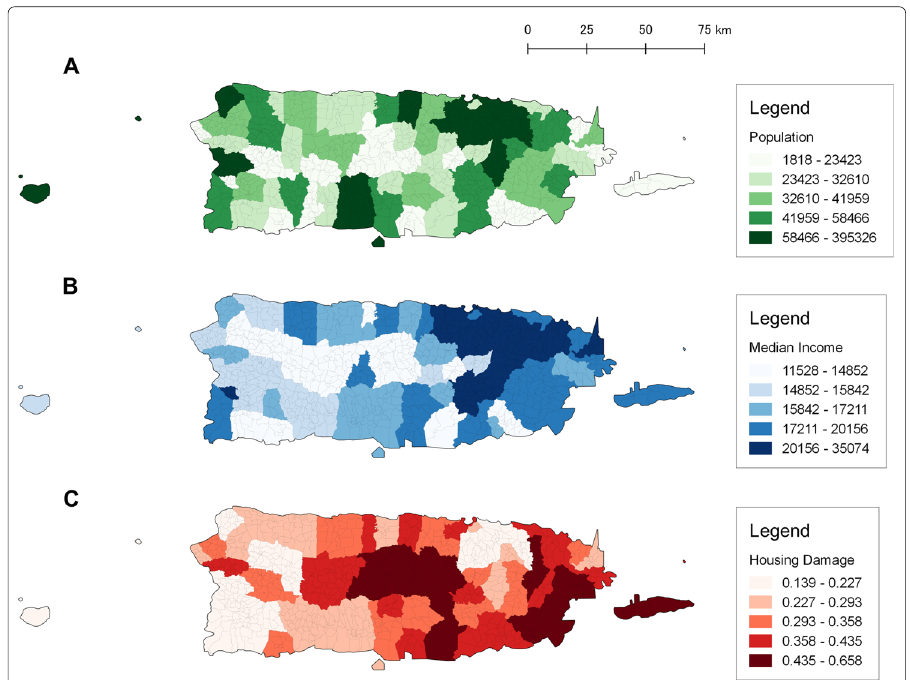
Fig. 2 Spatial plots of socio-demographics of counties in Puerto Rico. a Population distribution from national census in Puerto Rico. b Median income data obtained from American Community Survey for Puerto Rico. c Housing damage rates obtained from FEMA in Puerto Rico due to Hurricane Maria. Path of Hurricane Maria is shown in gray dotted